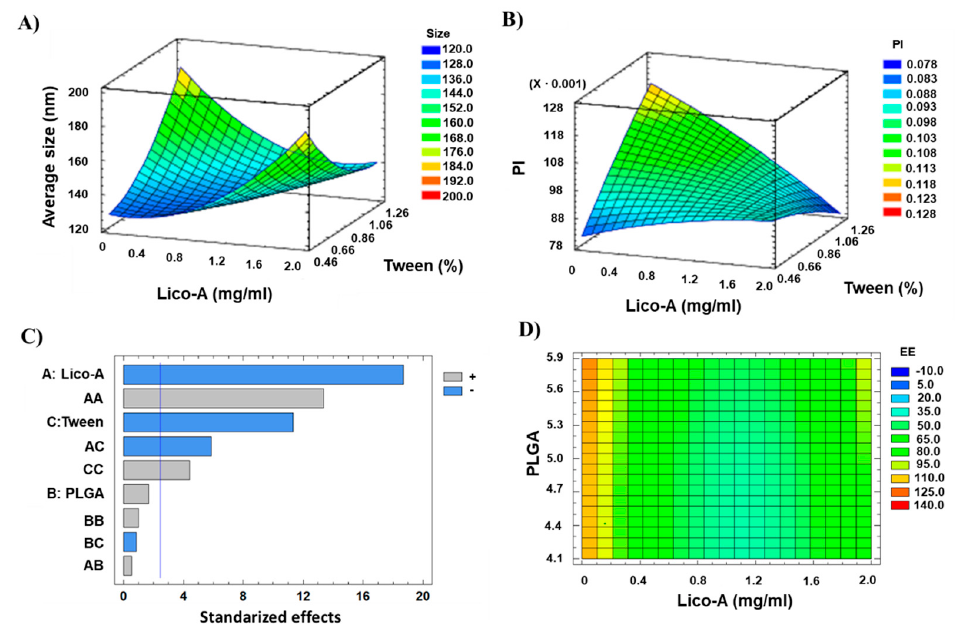
Figure 2. Design of experimental results. ( A ) Surface response plot for Z av , ( B ) Surface response plot for PI, ( C ) Pareto chart for EE (A: Lico-A concentration; B: PLGA concentration; C: Tween concentration; vertical blue line indicates significant effect), ( D ) Contoured surface response plot for EE.